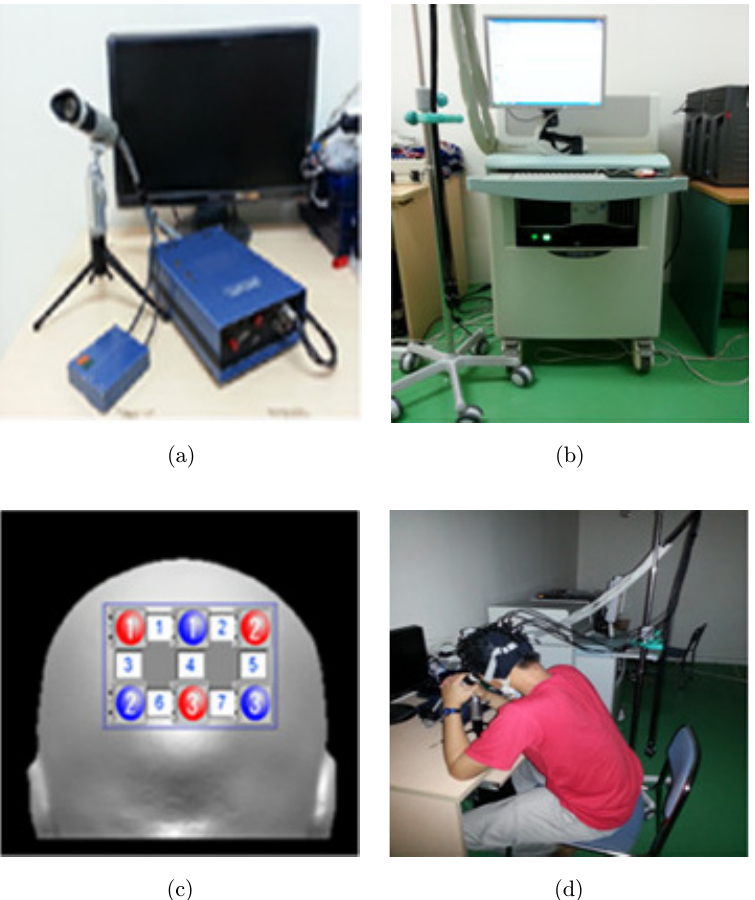
Fig. 1. Experimental setup. (a) Papillometre, (b) Foire-3000, (c) Location of probes and (d) Participant doing